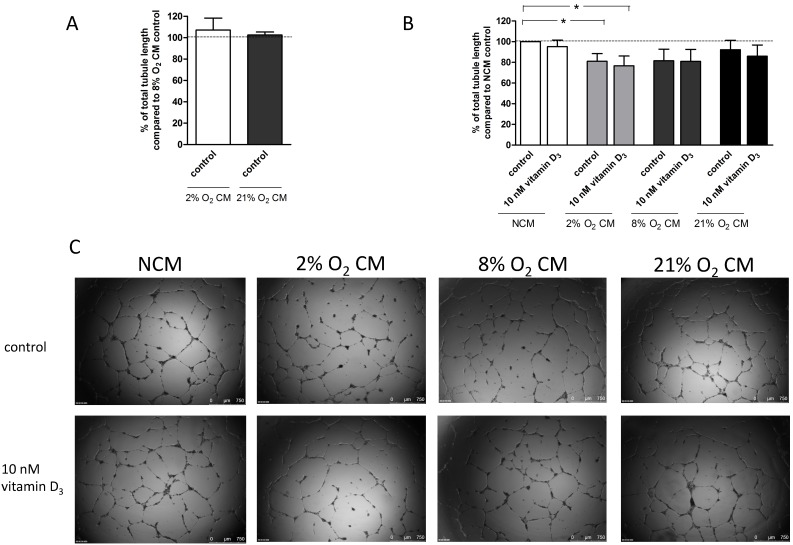
Effect of villous explant conditioned medium (2% O2, 8% O2, 21% O2 CM) and 1,25(OH)2 vitamin D3 on capillary-tube formation in a Matrigel assay.ECFCs were cultured in endothelial basal medium (EBM) +25% CM (A–C). Capillary-tube formation (average total tubule length per microscopic field) was analyzed after 14 h by visual microscopy at 2.5 magnification. Data are expressed as percentage of control (2A: 8% O2 CM+0 nM vitamin D3; 2B: NCM+0 nM vitamin D3). Results represent mean values of total tubule length ± SEM of at least 9 independent experiments; *P<0.05 vs. control, C: Representative photomicrographs of ECFCs after plating on Matrigel cultured in EBM+25% v/v CM. Scale bar represents 750 µm.